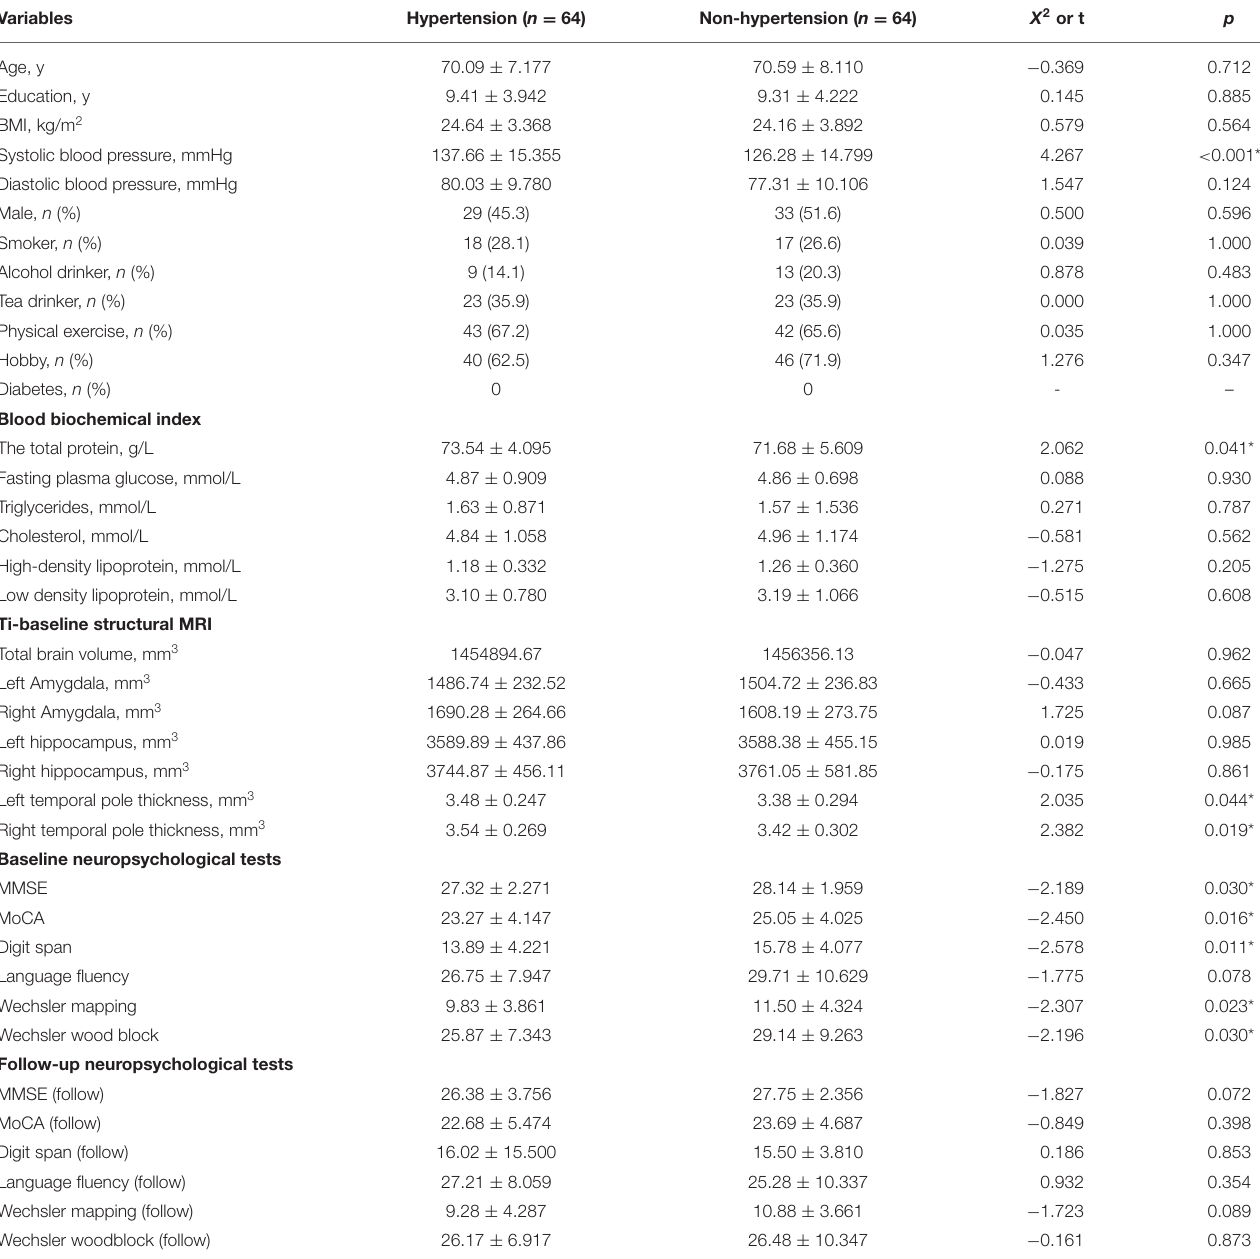
TABLE 1 | General demographic data between the two groups.